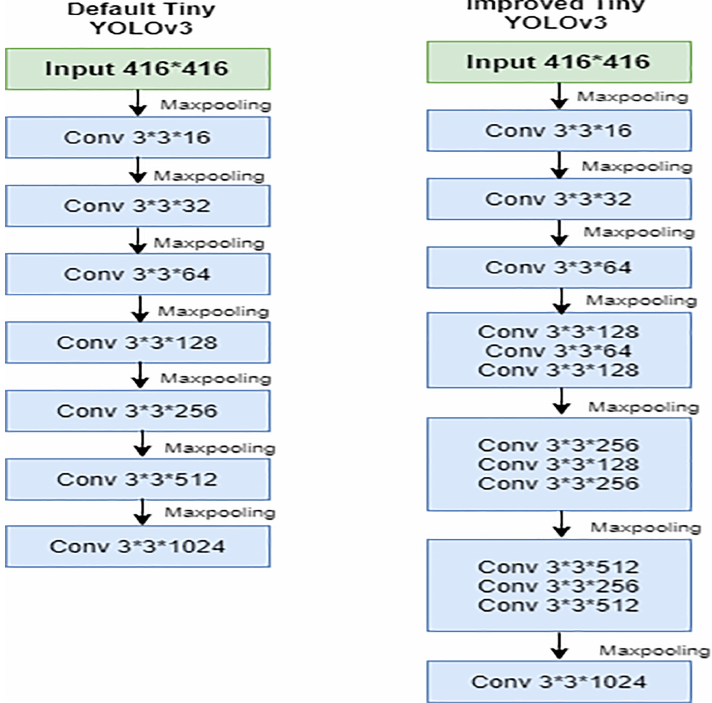
Figure 6. Improved and default